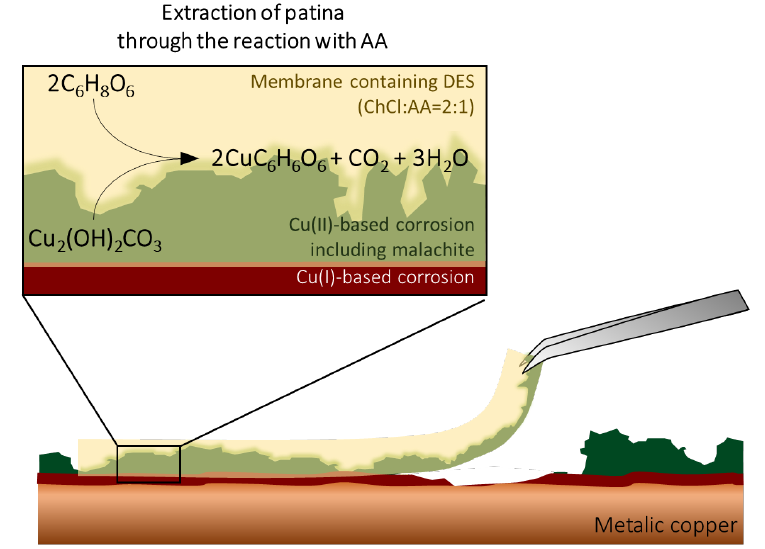
Figure 5. Schematic illustration of corrosion removal process of DES integrated with cellulose-based membranes.